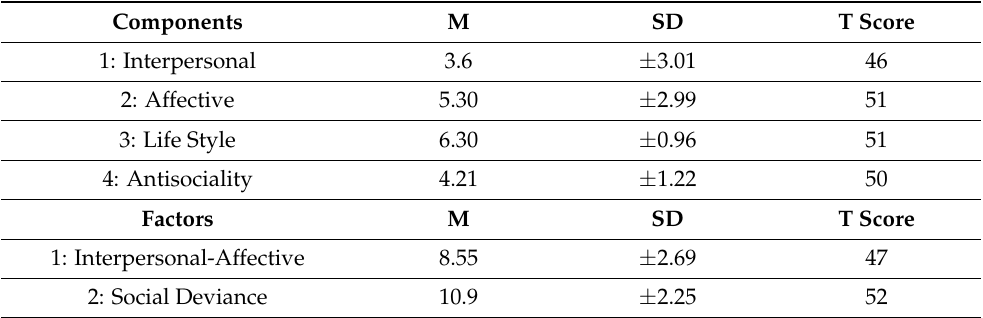
Table 3. Results of